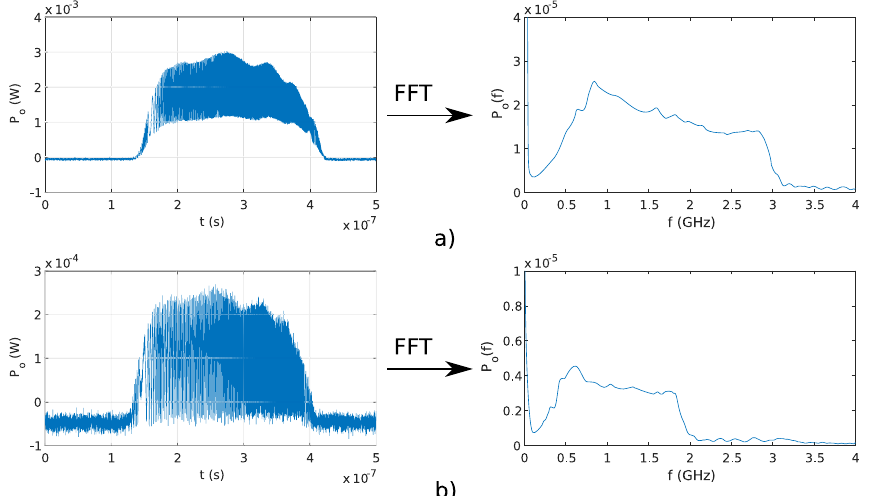
Figure 11. Generated chirp signals ant their spectrum: ( a ) with Michelson fiber interferometer where OPD ∆ L = 0.033 m and ( b ) Fabry–Perot fiber interferometer where OPD ∆ L = 0.02